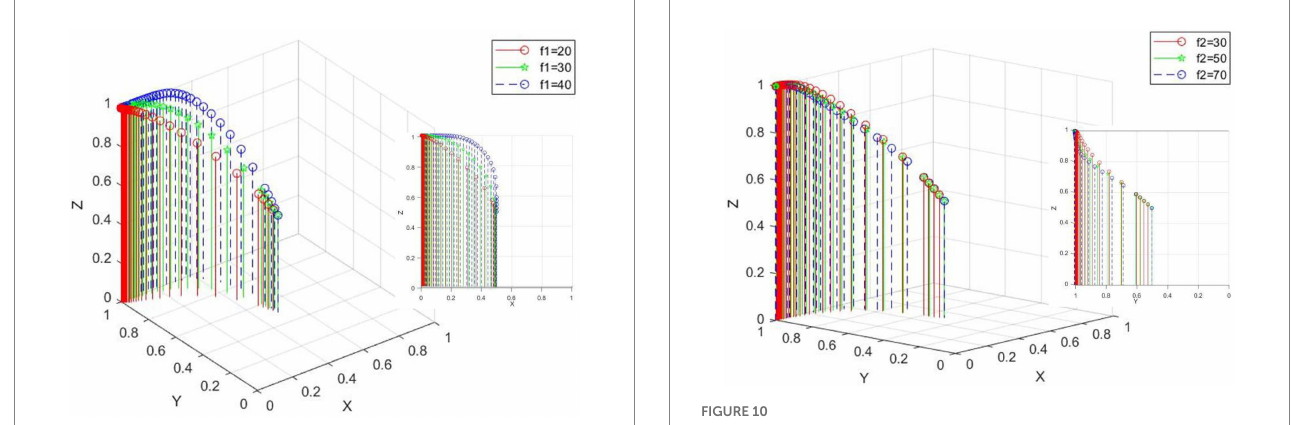
FIGURE 8 Map of the impact of the government on the amount of fines imposed on marine ranching companies (Scenario 2).